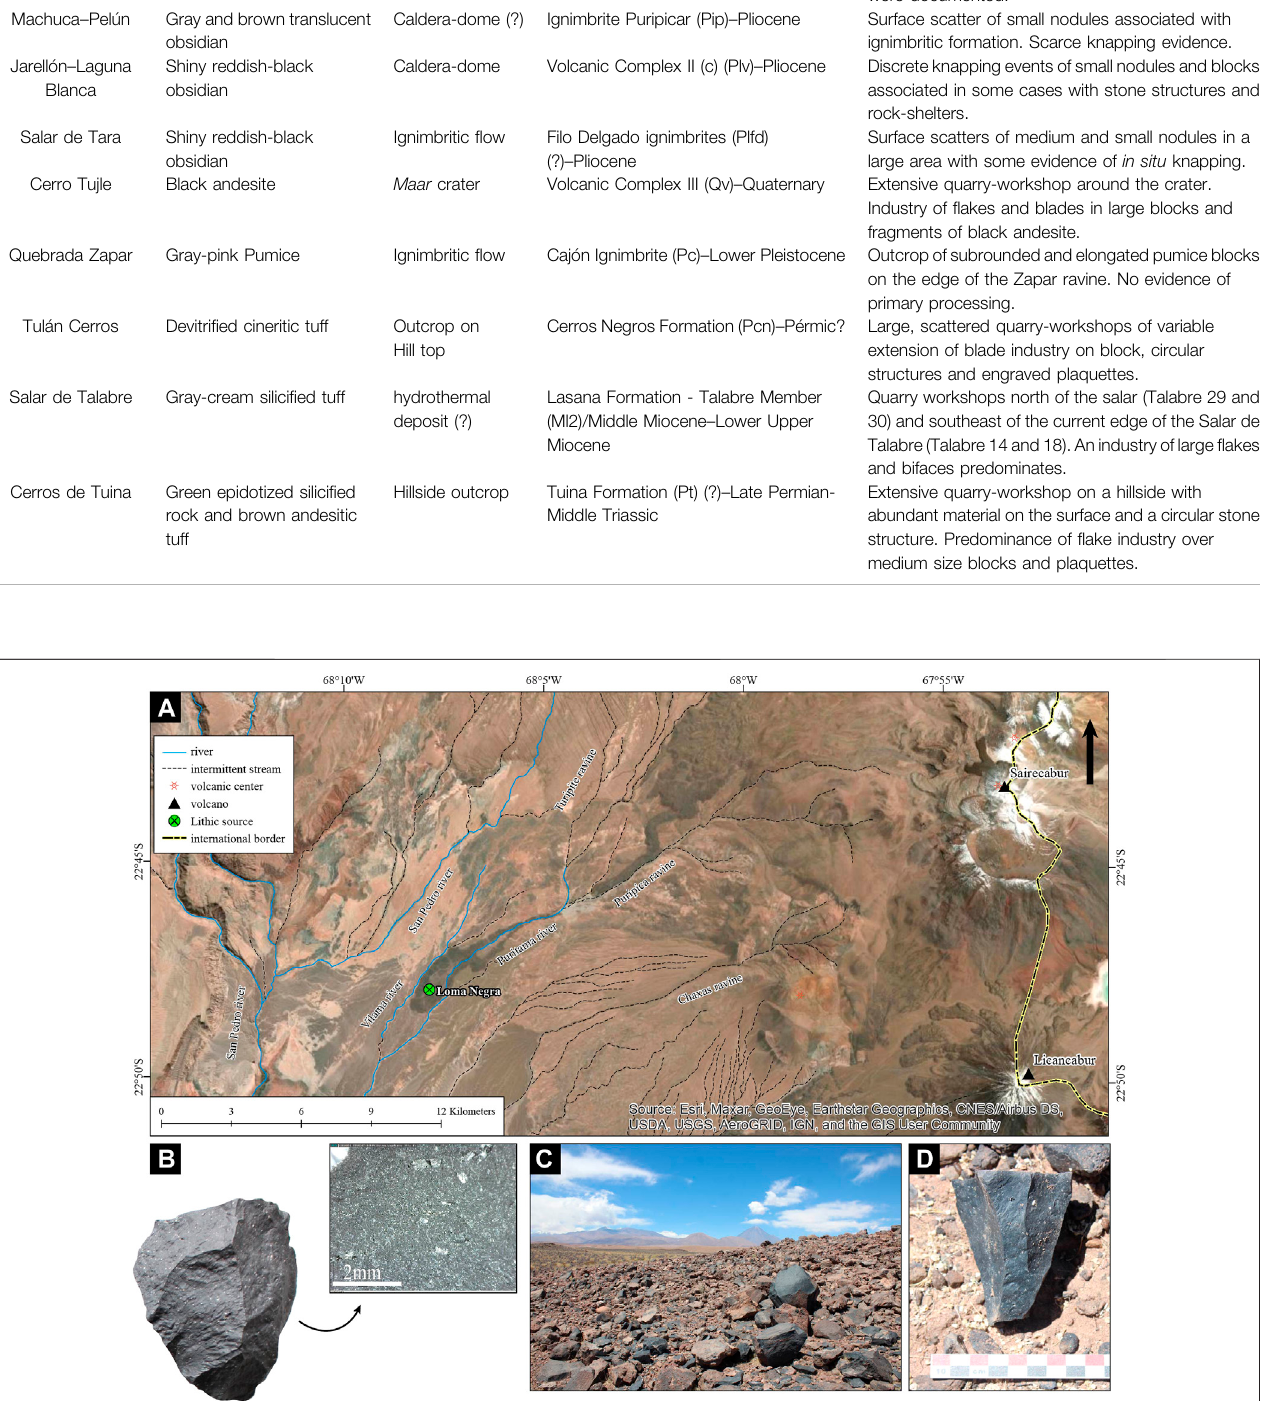
Frontiers in Earth Science |